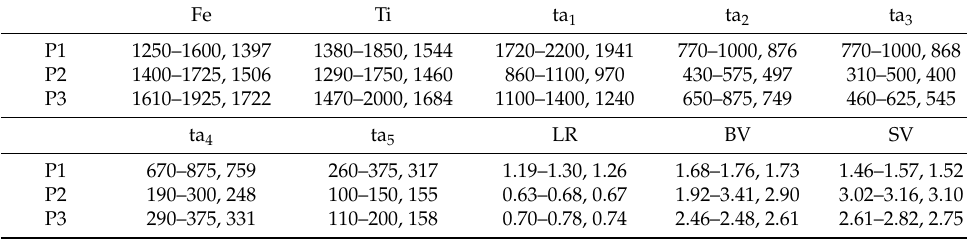
Table 5. Male adults of Microtendipes robustus sp. nov. Length (in µ m) and proportions of leg ( n = 5). Fe Ti ta 1 ta 2 ta 3